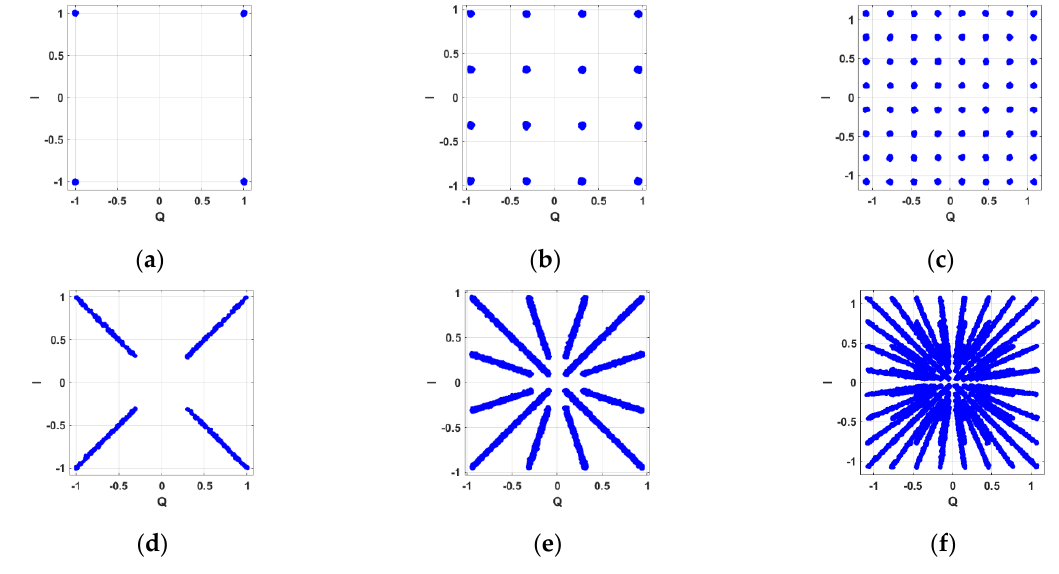
Figure 9. Constellation of ( a ) QPSK original, ( b ) 16QAM original, ( c ) 64QAM original, ( d ) reshaped QPSK, ( e ) reshaped 16QAM, and ( f ) reshaped 64QAM.